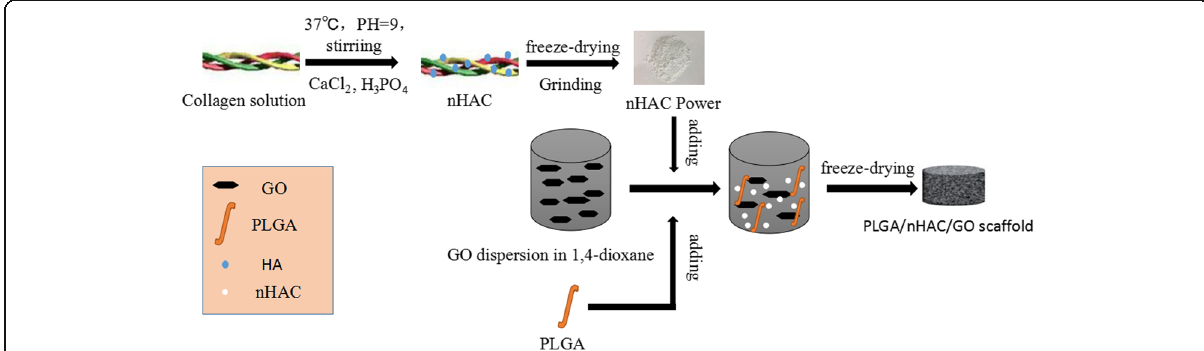
Fig. 1 Schematic diagram of the fabrication process for nHAC/PLGA/GO